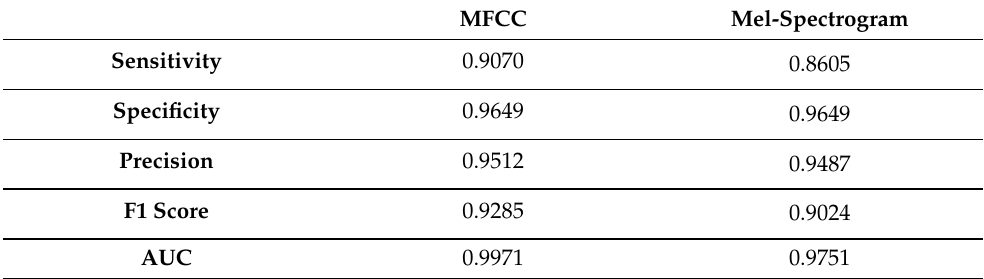
Table 2. Comparison of scoring data between the MFCC and Mel-spectrogram feature extraction.